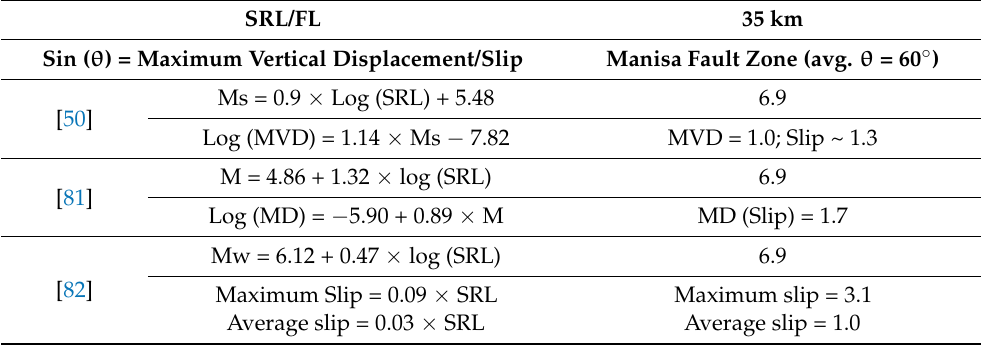
Table 6. Regression of SRL (surface rupture length), magnitude (Ms/M) and vertical displacement (MVD/MD) values calculated for the Manastır and Mugırtepe faults and the Manisa Fault Zone. SRL/FL 35 km Sin ( θ ) = Maximum Vertical